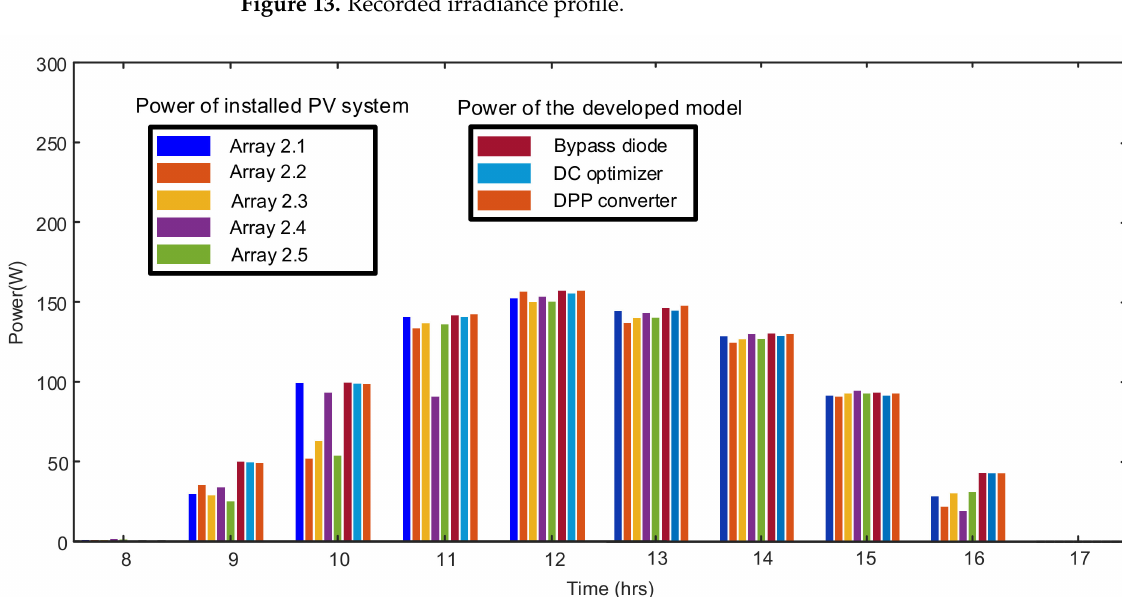
Figure 13. Recorded irradiance profile.